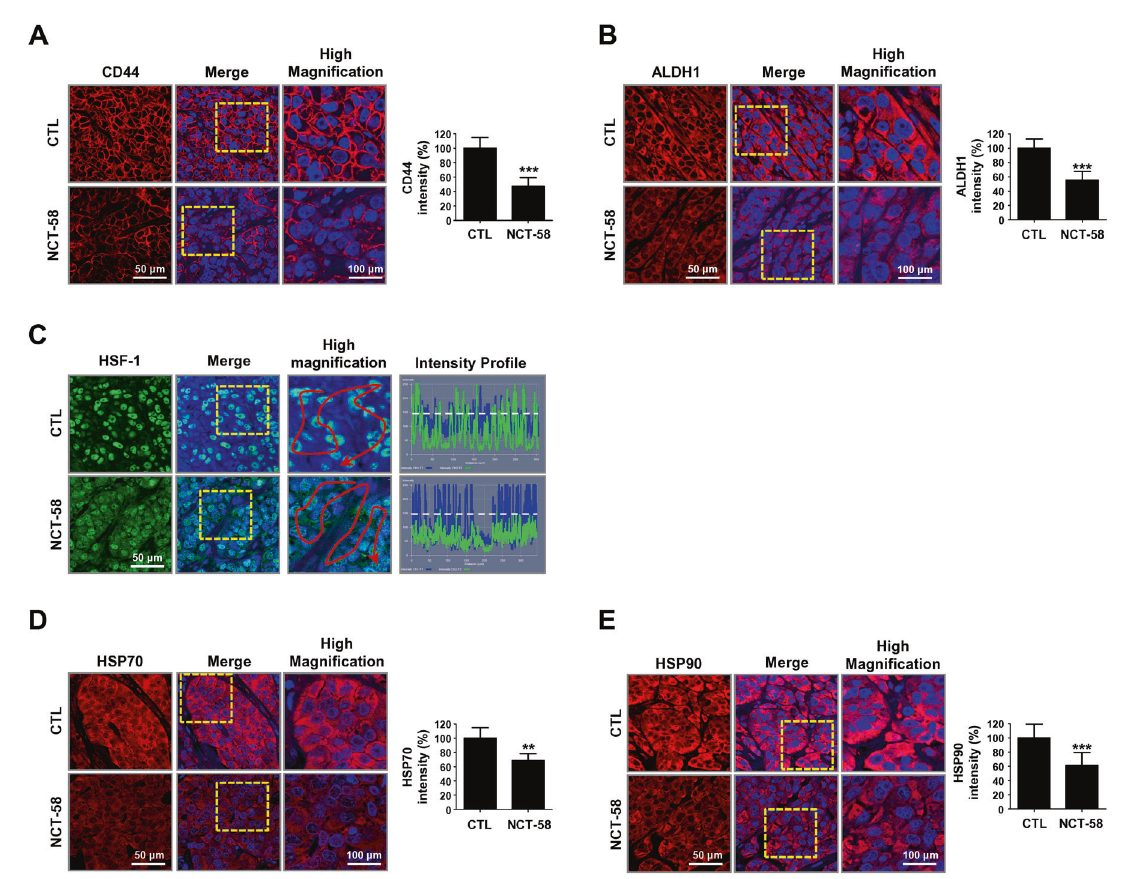
Fig. 6 NCT-58 suppresses BCSC-like properties and downregulates the expression of HSF-1, HSP70, and HSP90 in vivo. A, B Following exposure to NCT-58, CD44 and ALDH1 expression levels were markedly downregulated in JIMT-1 xenograft tumors. The fl uorescence intensities of CD44 ( A , *** p < 0.001, n = 6) and ALDH1 ( B , *** p < 0.001, n = 6) were analyzed using a histogram tool. C – E Effect of NCT-58 on induction of the HSR in vivo. C NCT-58 administration resulted in a decrease in nuclear expression of HSF-1 (green). Fluorescence intensity of HSF-1 localized in the nuclei is represented in arbitrary units as de fi ned by the software using the intensity pro fi le tool. D , E NCT-58 downregulated both HSP70 and HSP90 expression. Quantitative graphs of fl uorescence intensities of HSP70 ( D , ** p < 0.01, n = 6) and HSP90 ( E , *** p < 0.001, n = 6) signal, shown in the bottom panels, respectively. Tumors were harvested within 24 h of the last administration of NCT- 58 for immunohistochemistry assessment. Data were analyzed by unpaired Student ’ s t -test.